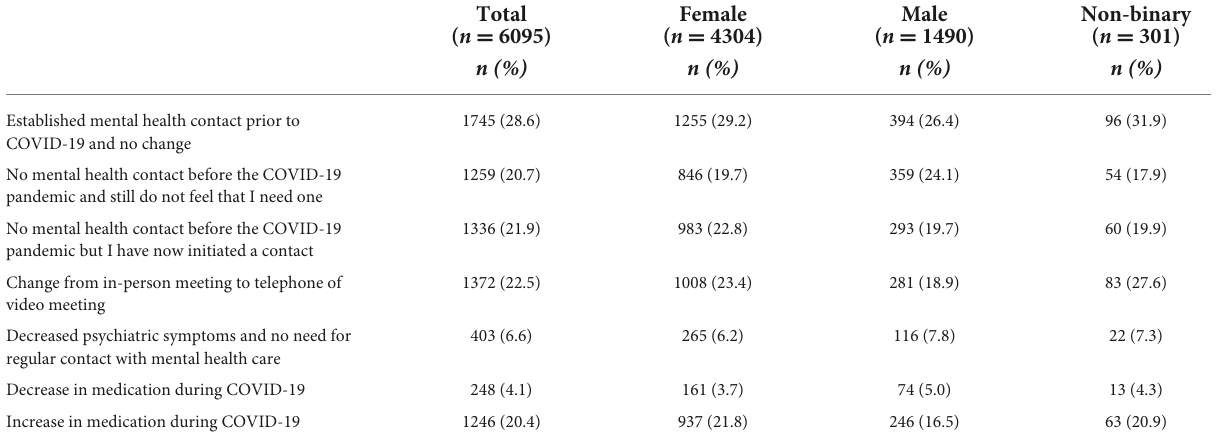
TABLE 6 Changes in health care contacts and treatment during the COVID-19